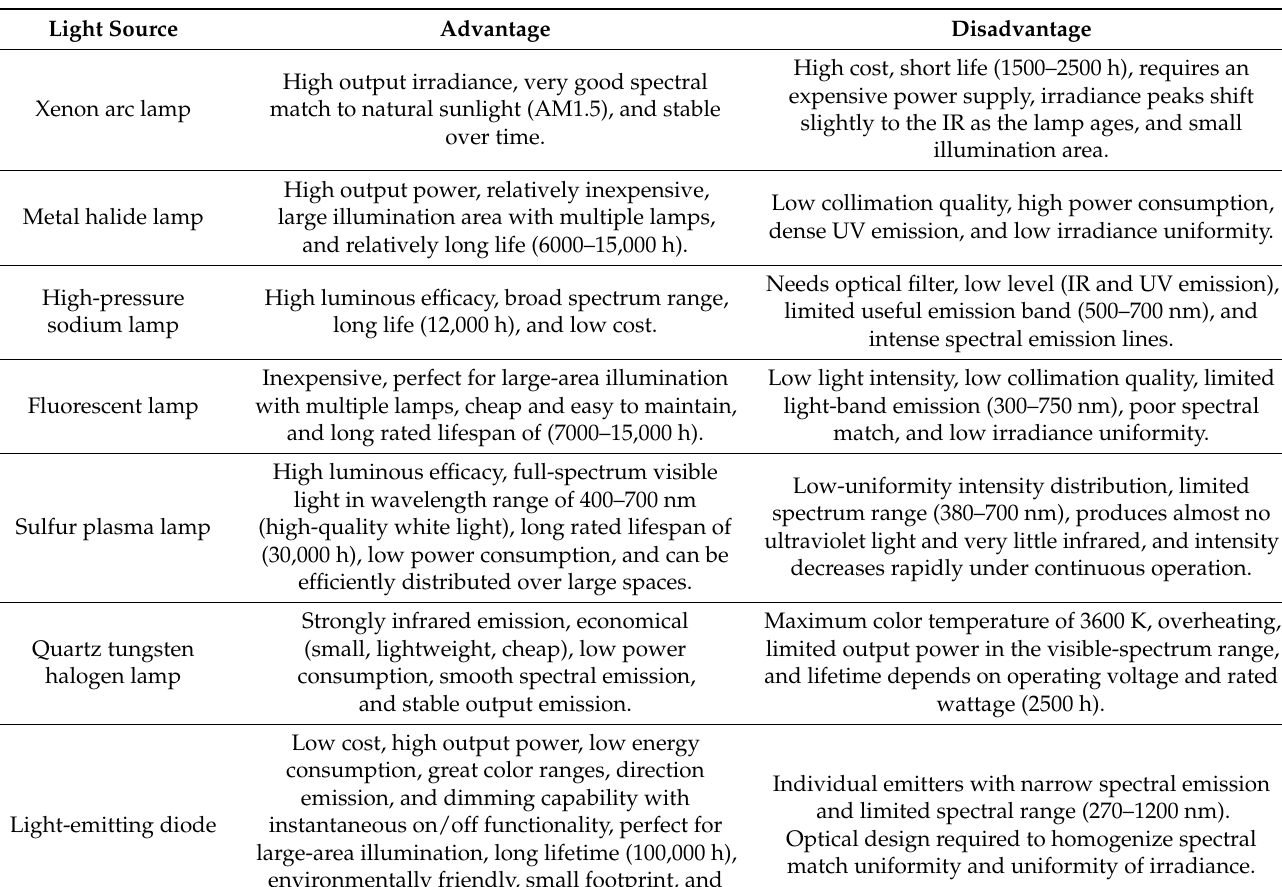
Table 1. The advantages and disadvantages of common solar simulator light